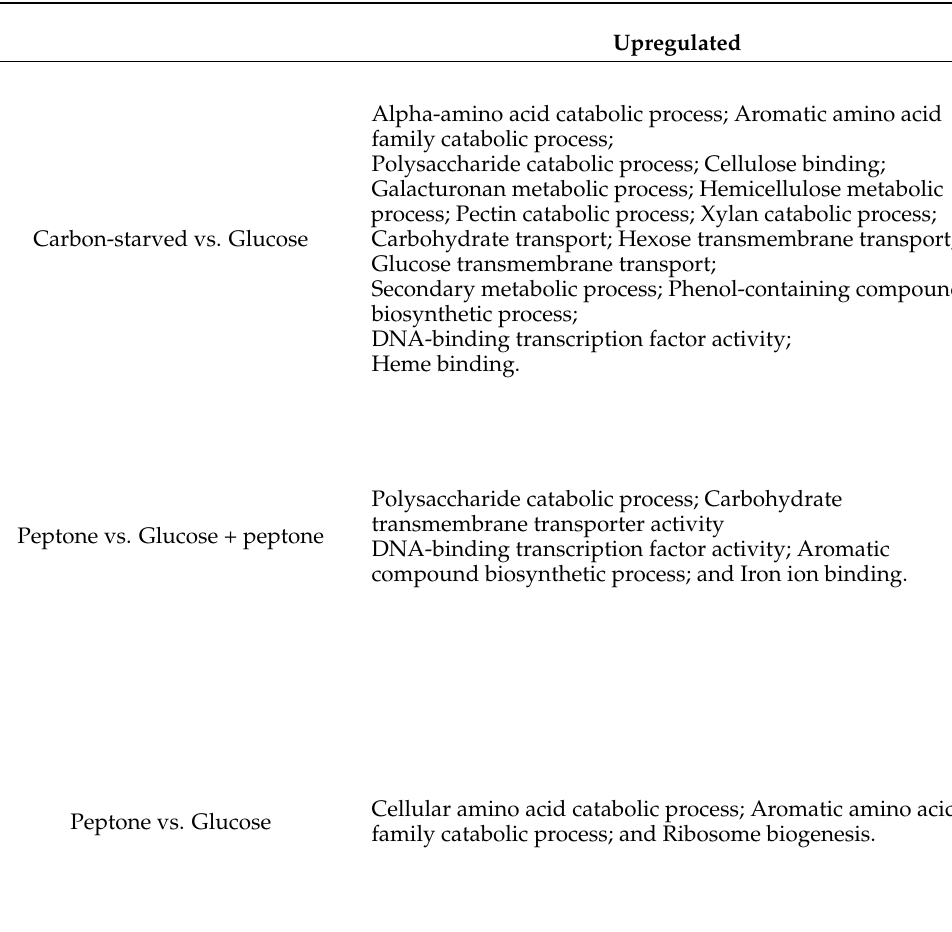
Carbon-starved vs.